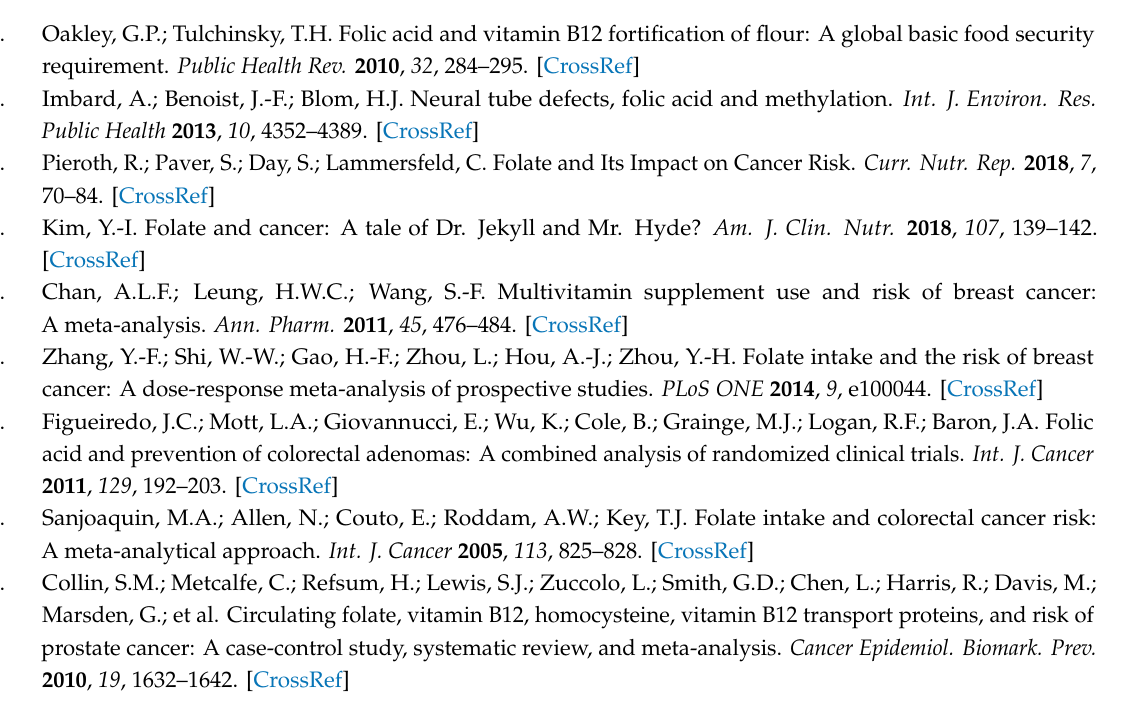
Figure S1: MA plot and Volcano plot. Figure S2 (A) Top 3 disease pathways; (B) Mammary tumour disease pathway (C) Top upstream regulator pathway. Table S1: Dietary compositions. Table S2: qRT-PCR primer information. Table S3: Growth and energy intakes. Table S4: Di ff erentially expressed genes between CFA and HFA groups. Table S5: Gene Ontology. Table S6: GSEA analysis (Hallmark). Table S7: GSEA analysis (Hallmark EMT). Table S8: GSEA analysis (Hallmark E2F targets). Table S9: GSEA analysis (C2). Table S10: Top disease pathways. Table S11: Top 5 networks Table S12: Top upstream regulators identified from Ingenuity Pathway Analysis. Table S13: Chip-seq enrichment analysis. Table S14: Validation of di ff erentially expressed Genes within RNA-seq